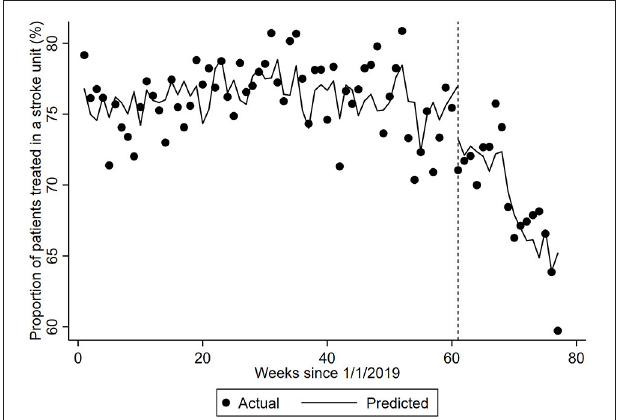
FIGURE 1 | Proportion of patients treated in a stroke unit. The dots represent the proportion of patients provided treatment in a stroke unit per week. The predicted proportion is the expected proportion is adjusted for the number of patients with different diagnoses and the corresponding number from the previous year (seasonality). Vertical hatched line represents week 61 of the interrupted time-series model with trends compared before and after this date, which coincides with the first COVID-19 related death. Coefficient − 0.2457 (95% CI − 0.4216, − 0.0697, p -value =